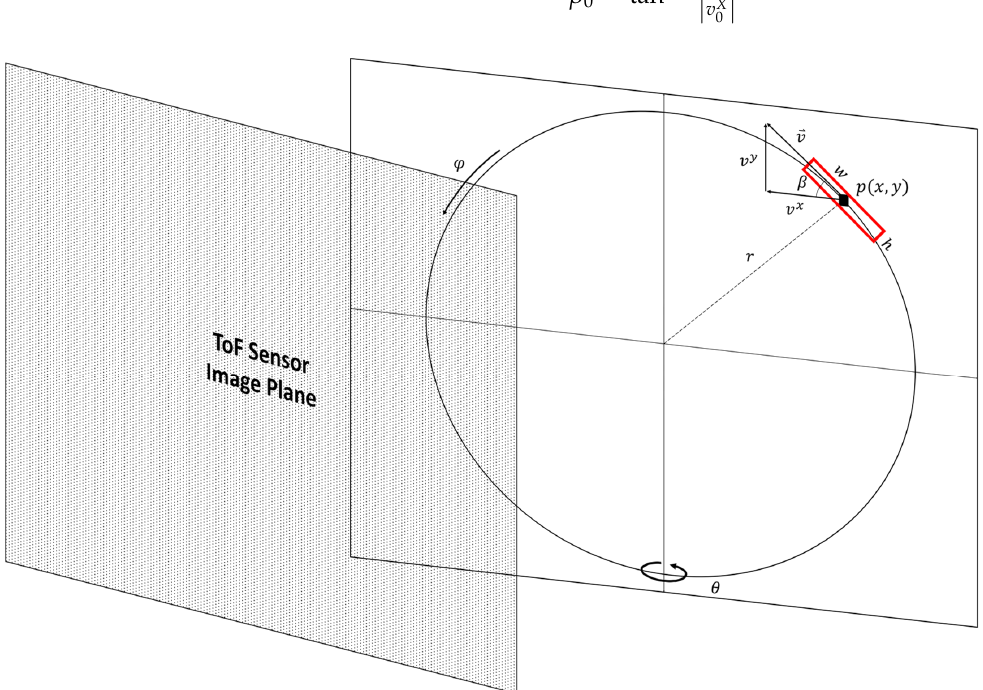
Figure 3. Radial motion with respect to the image plane of the ToF sensor. In Equation (4), | v X | and | v Y | are the magnitudes of the velocity component in the x-direction and y-direction, respectively, when the motion path of the pixel is not parallel with the image plane of the ToF sensor, | v x | and | v Y | are magnitudes of the velocity component in the x-direction and y-direction, respectively, when the motion path of the pixel is parallel with the image plane of the ToF sensor, β 0 is the rotation angle of the pixel when the motion path of the pixel is parallel with the image plane of the ToF sensor, and θ is the rotation angle between the image plane of the ToF sensor and the motion of the object. Using this relationship, we can then determine the velocity for a pixel with radial motion by solving the following: